Question: Judging by this figure, is the value going up or going down?
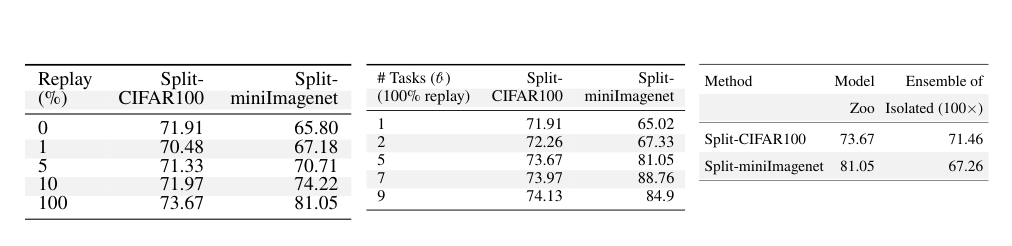
Answer: increasing